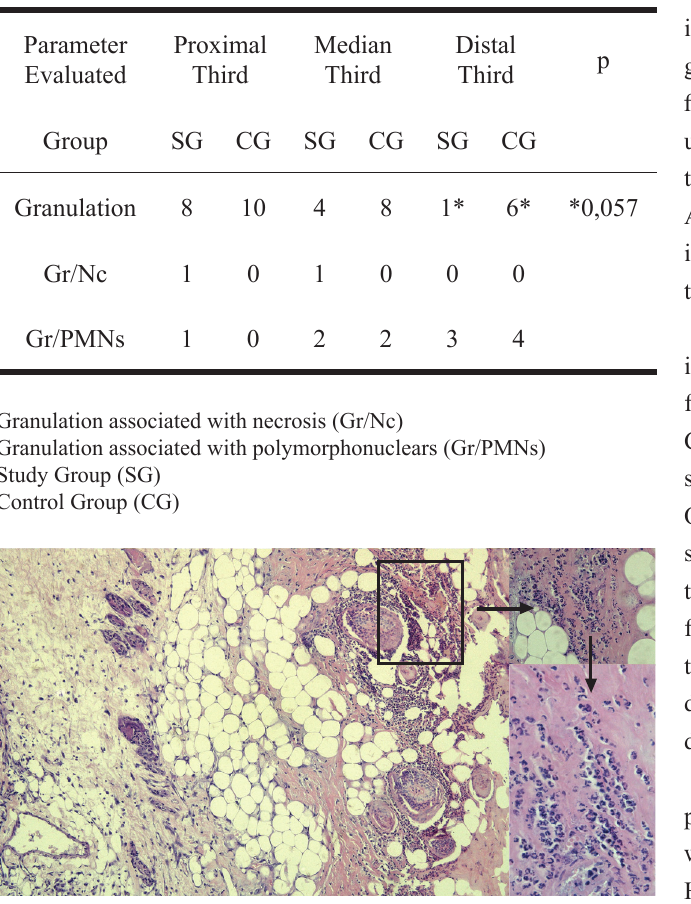
FIGURE 4 – Photomicrograph of histological skin section. Note the presence of granulation, vascular formation and edema. HE 100X. Above, a high-magnification view of the squared box showing polymorphonuclears. HE 200X. Below, the polymorphoneclears cells in a magnification of